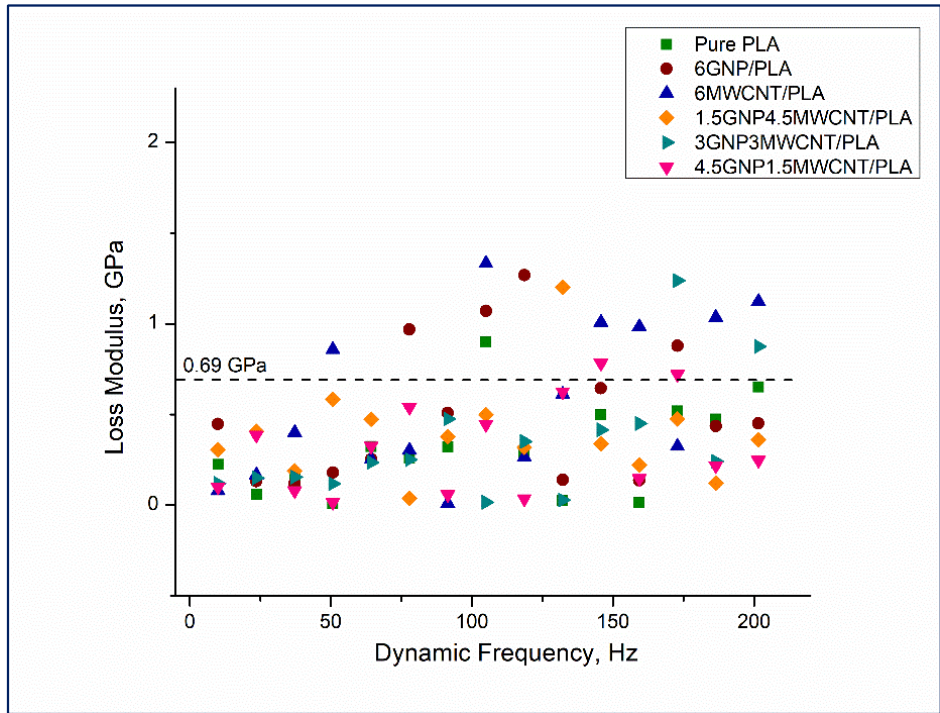
Figure 9. Loss modulus versus dynamic frequency for the whole series of nanocomposite samples including neat PLA.